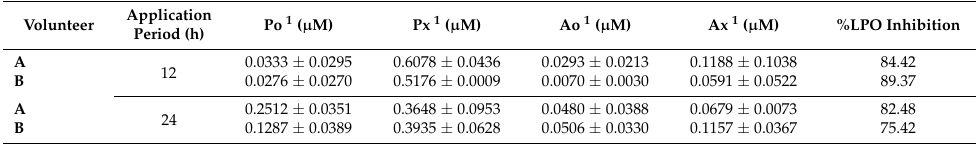
Figure 5. Concentration ( µ M) values after UV irradiation of the strips obtained from control, control-texiles, and biofunctional textiles after 12 and 24 h of application onto the skin of the two healthy volunteers. UW is for ‘untreated wool’; T1 refers to Textile # 1. All analyses were performed in triplicate. Table 4. LPO values determined using strip irradiated at 1 × 10 5 µ W/cm 2 for 45 min. % LPO inhibition mean and standard deviation are reported. The meaning of P 0 , P x , A 0 , and A x is explained in Section